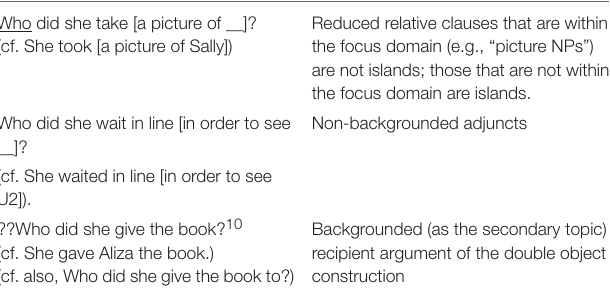
TABLE 4 | Cases that follow from an information structure account, but not from an account that attempts to derive the restrictions from configurations of syntactic